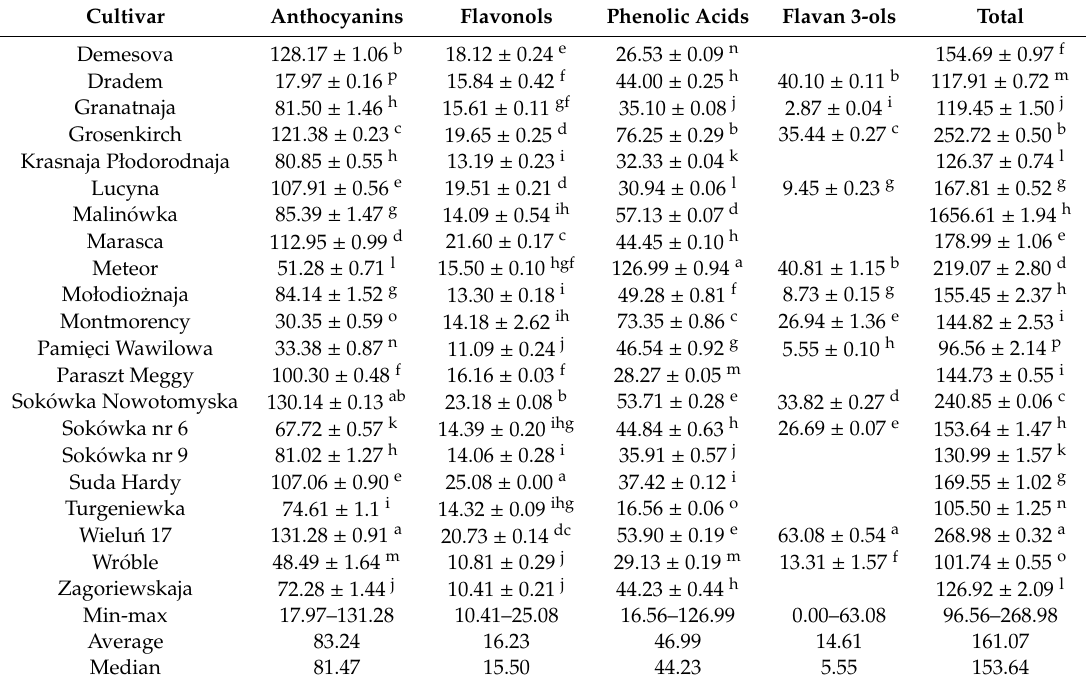
Table 3. Phenolic compound content (mg / 100 g FW) in sour cherry fruit of 21